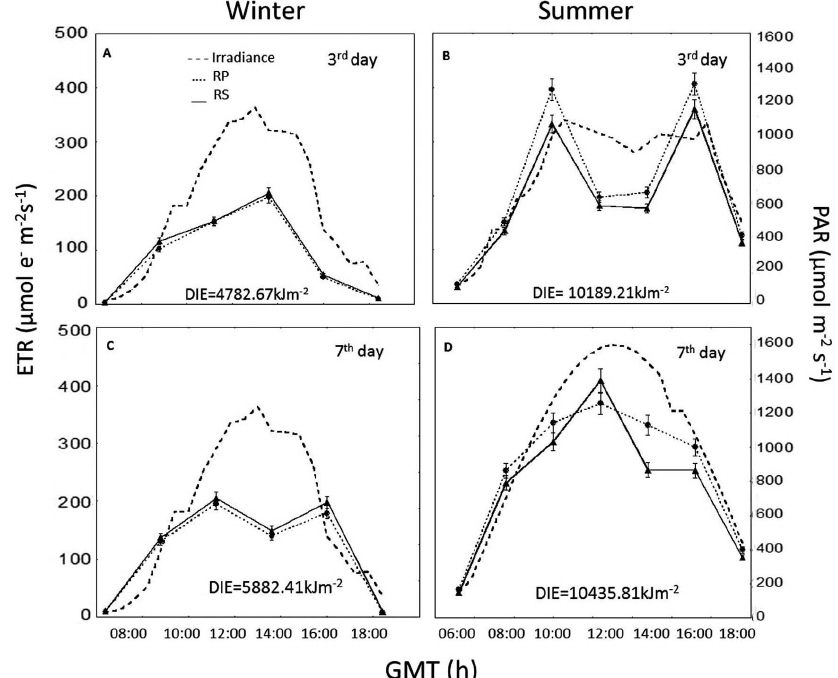
Fig. 5. – Daily cycle of in situ ETR expressed as μmol electrons m –2 s –1 in C. tamariscifolia during the experimental period (3 rd and 7 th days) in algae incubated in 1.5-L cylindrical vessels. The algae were collected in winter (February) (A, C) and summer (July) (B, D) and from rockpools (RP) (dotted lines) and rocky shores (solid lines) (RS). The daily irradiance of PAR expressed as μmol photons m –2 s –1 (straight lines). The average daily integrated irradiance (DIE) expressed as kJ m –2 during the experimental period is